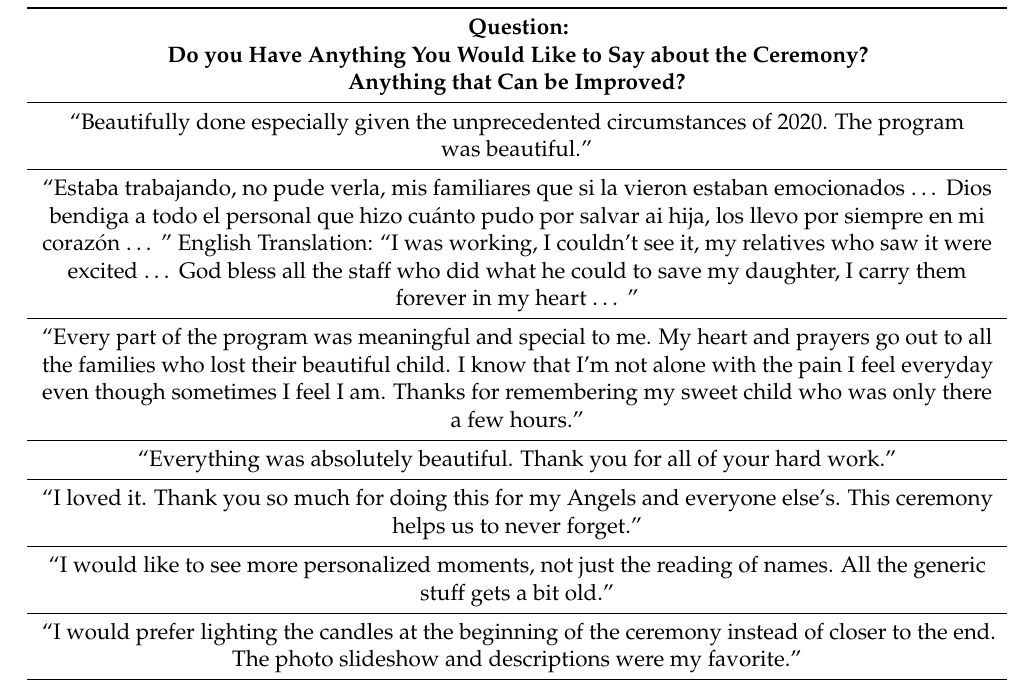
Table 1. Selected qualitative results from system-wide remembrance ceremony